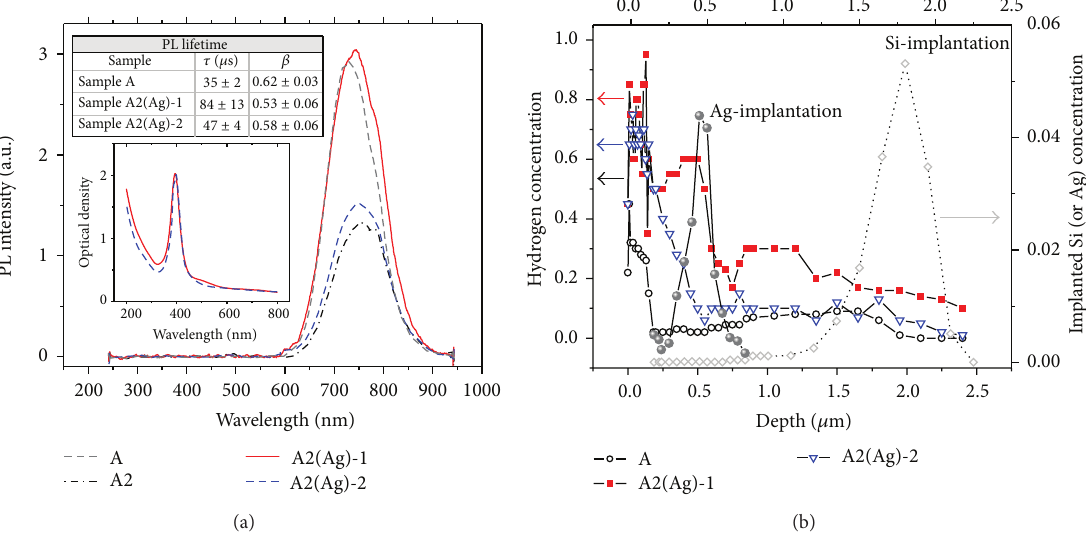
Figure 6: (a) PL emission from samples A, A2, A2 (Ag)-1, and A2 (Ag)-2. Inset graph shows the optical absorption of each sample. PL lifetime fitting parameters are shown in the inset table. (b) Hydrogen depth profile of each sample, Ag depth profile (filled gray circles) by RBS, and Si depth profile (open gray rhombs) by SRIM simulation are shown for